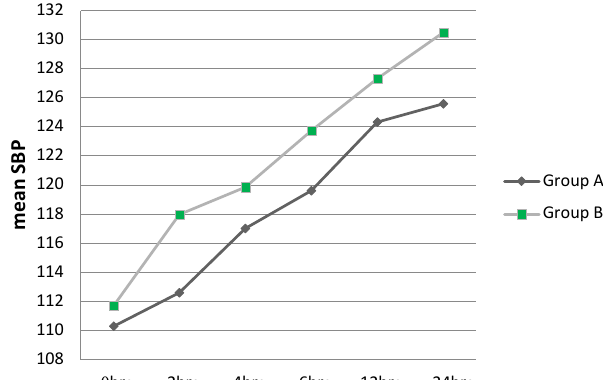
and weight between the two groups (Table1).